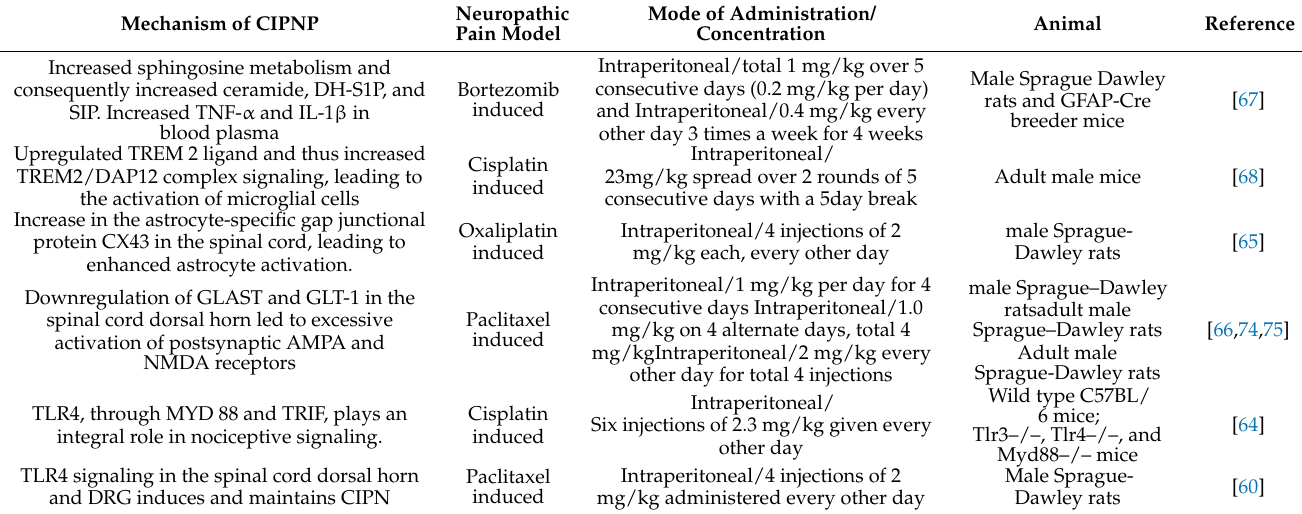
Table 7. Previous studies investigating the mechanisms by which anticancer drugs exert their effects. Mechanism of